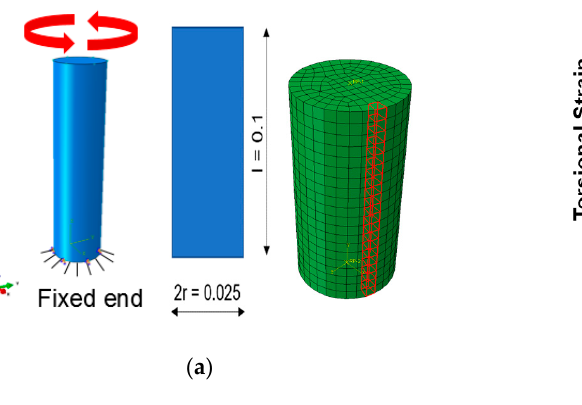
Figure 2. ( a ) Cylindrical column, and ( b ) torsional shear strain.